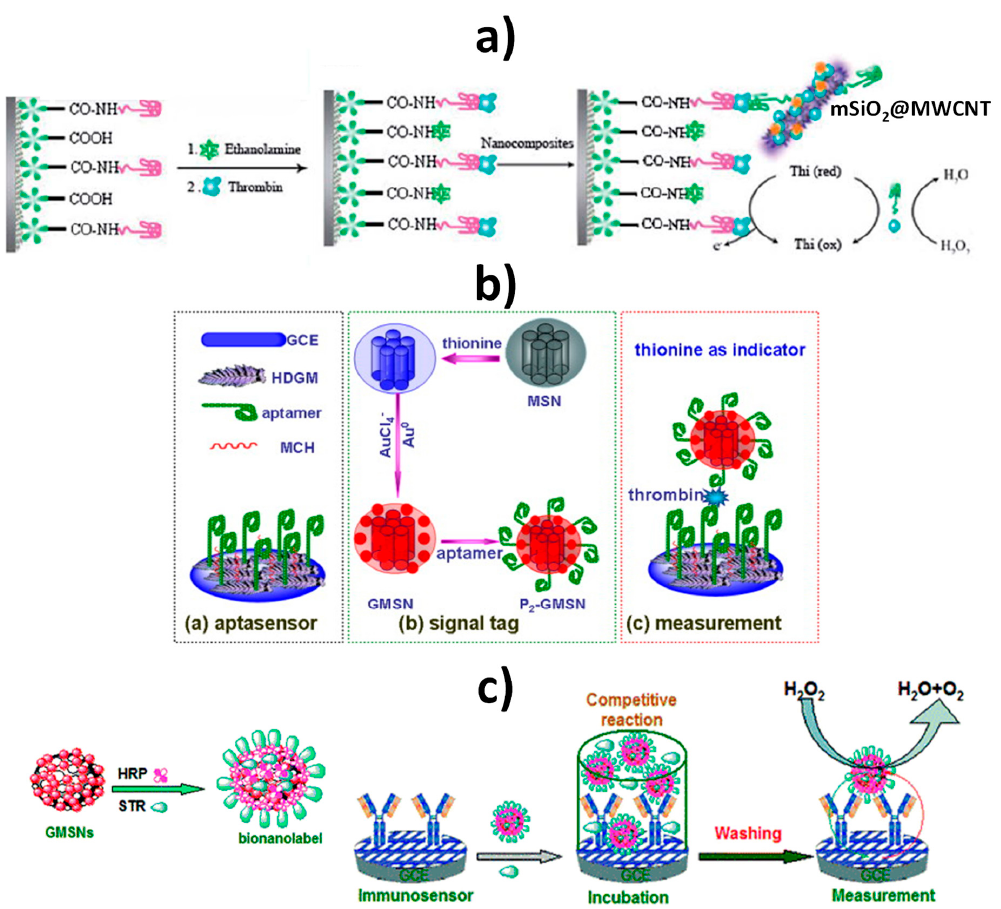
Figure 15. Sandwich aptasensors for thrombin developed at a PAMAM–rGO-GCE using mSiO 2 @MWCNT decorated with Thi, platinum nanoparticles (PtNPs), and